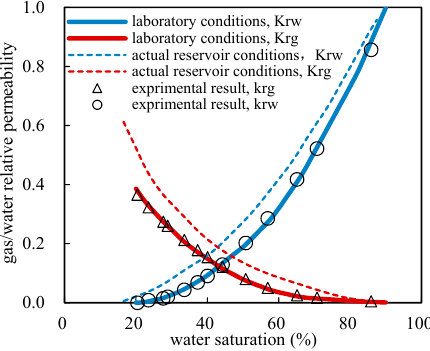
Figure 16. Gas/water relative permeability curves of core 24 # .